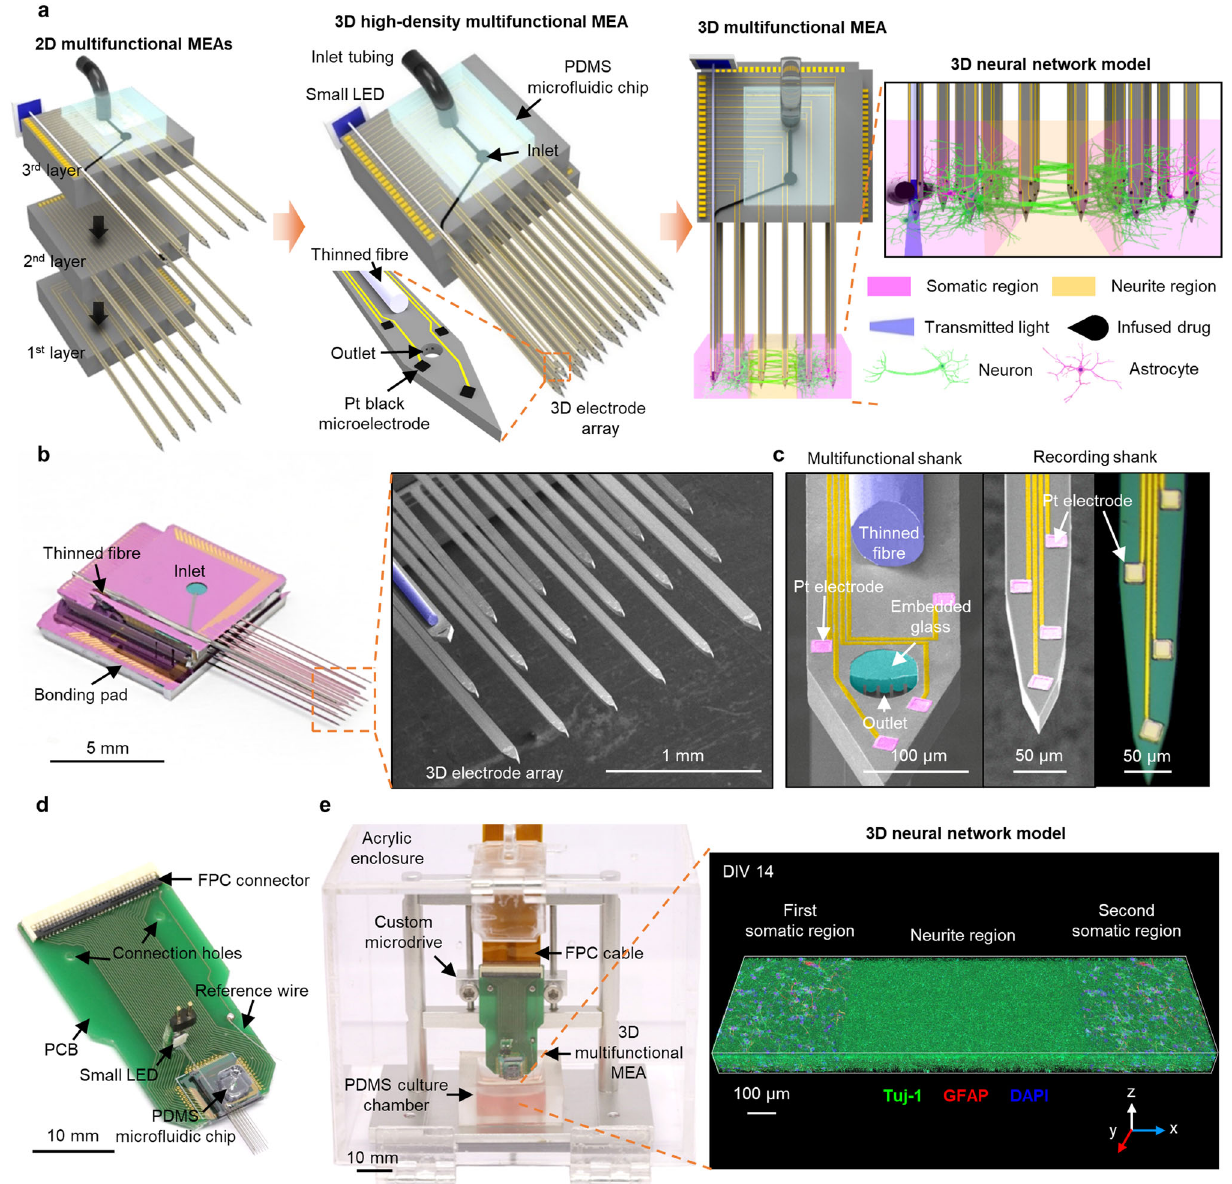
Fig. 1 3D high-density multifunctional microelectrode array (MEA) system. a Schematic illustrations showing three 2D multifunctional MEAs before stacking and bonding (left), assembled 3D high-density multifunctional MEA with a PDMS fl uidic interface and the multifunctional shank for optical and chemical stimulations (middle), and the application to 3D neural network model in vitro compartmentalized with two somatic and neurite regions (right). b Photograph of the 3D multifunctional MEA (left; scale bar, 5 mm) and scanning electron microscopy (SEM) image of the 3D electrode array (right; scale bar, 1 mm). c SEM image of the multifunctional shank with thinned optical fi ber (blue), embedded glass (green) and outlet of microchannels underneath the embedded glass layer (left; scale bar, 100 μ m), and SEM and optical images of the recording shanks with platinum (Pt) electrodes (right; scale bar, 50 μ m). d Photograph of packaged 3D multifunctional MEA integrated with small light-emitting diode (LED) and fl exible printed circuit (FPC) connector on a printed circuit board (PCB). (Scale bar, 10 mm). e Photograph of the 3D multifunctional MEA system with a custom microdrive and a PDMS 3D culture chamber in an acrylic enclosure (left; scale bar, 10 mm), and 3D rendered confocal fl uorescence image of the compartmentalized two-group neural network at day 14 in vitro (DIV) showing neurites (green; Tuj-1), astrocytes (red; GFAP), and nuclei (blue; DAPI). Scale bar, 100 μ m. Fabrication and packaging of the MEA system were independently repeated at least ten times with similar results to ensure reproducibility, and the representative images are shown in the fi